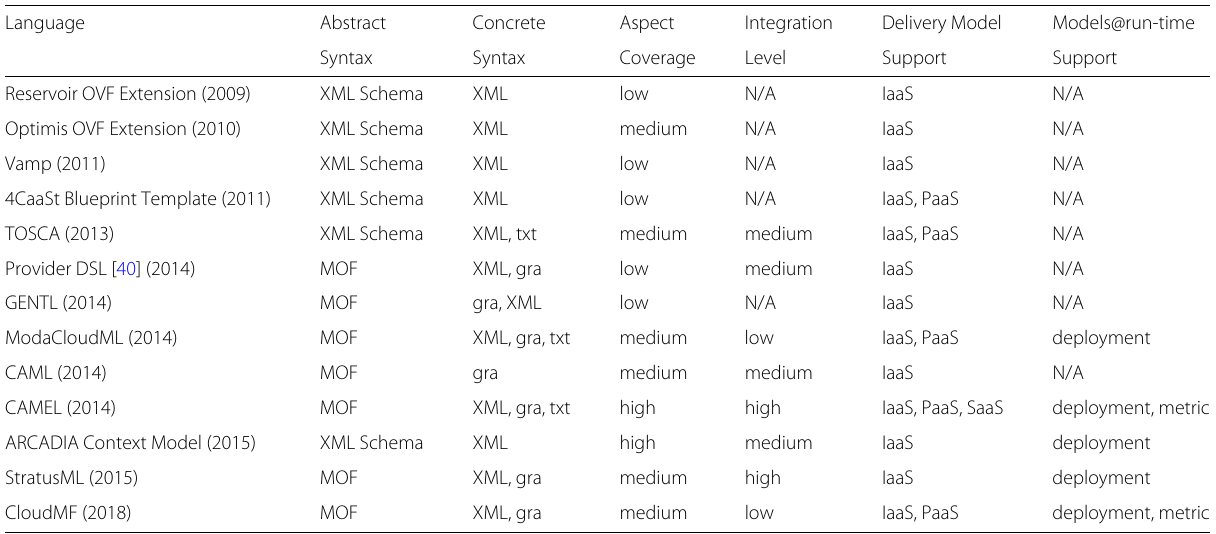
Table 5 Cloud Languages Comparative Analysis